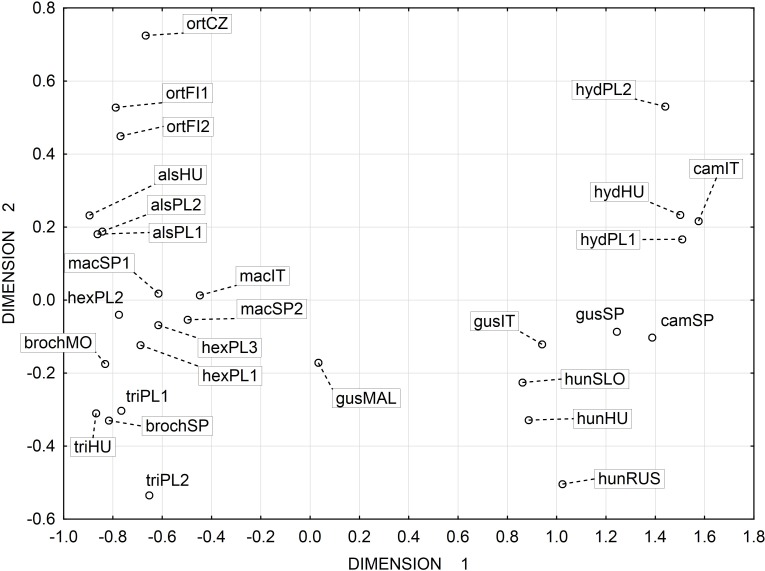
Multidimensional scaling based on a correlation matrix of Mahalanobis distance for seed traits among 28 populations of Elatine.For acronyms, see Table 1